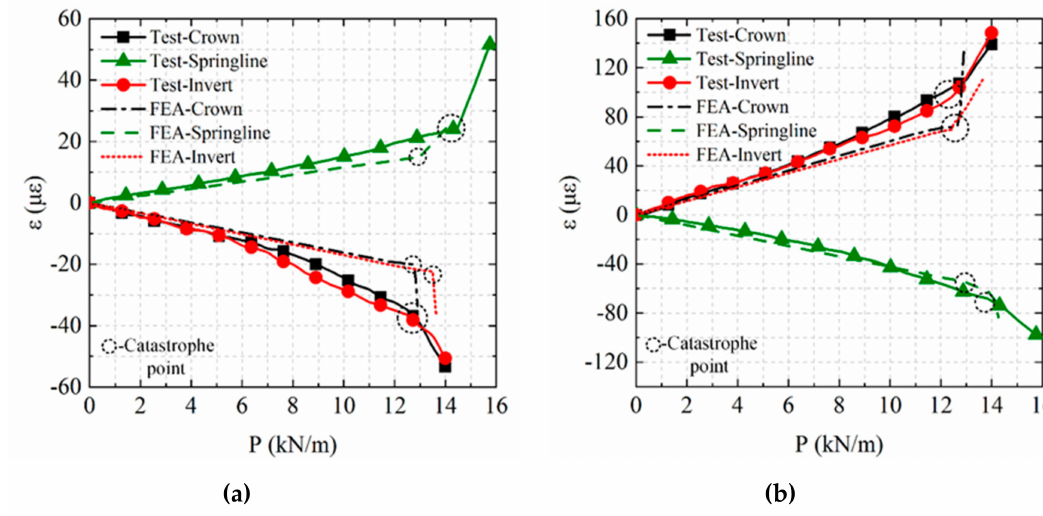
Figure 24. Load–strain curves of the pipes containing cracks at di ff erent positions: ( a ) outer wall and ( b ) inner